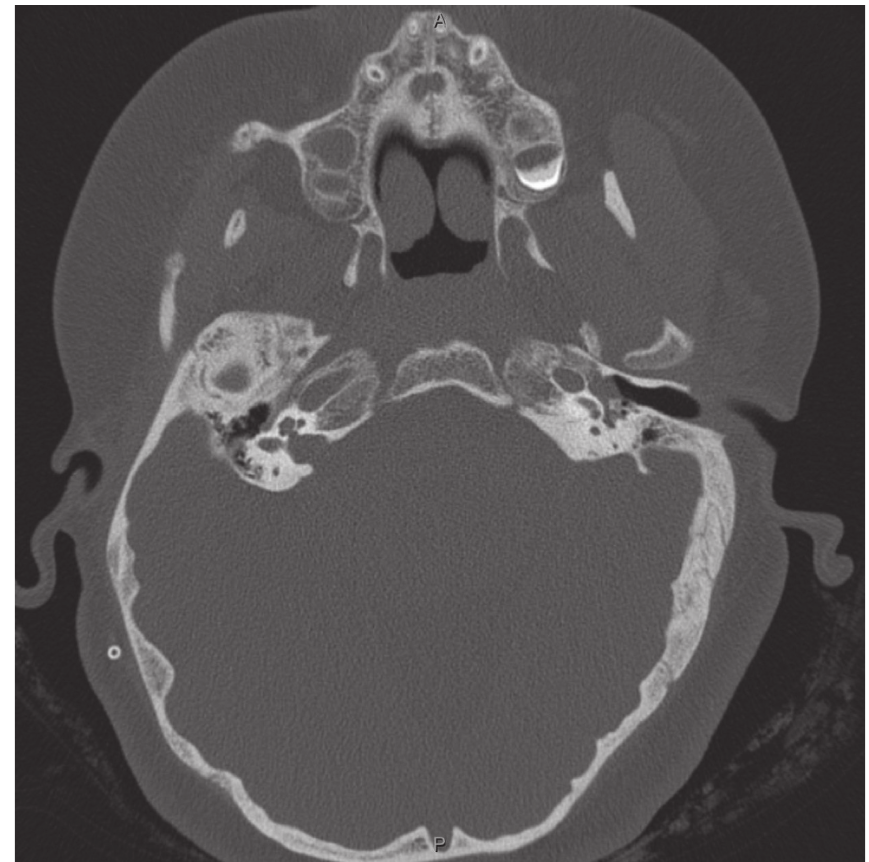
Figure 4: CT axial view. There is no visible stapes. There is no direct continuity between the mass and the carotid or jugular